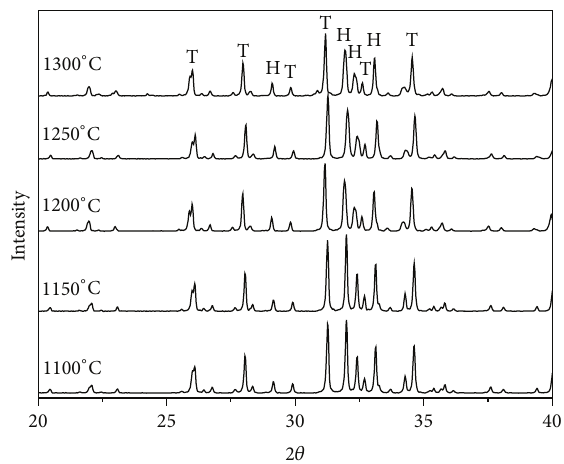
Figure 1: X-ray diffraction patterns of 60TCP40HA according to sintering temperature between 1100 ∘ C and 1300 ∘ C. T: tricalcium phosphate, H: hydroxyapatite, and 2 𝜃 : the take-off angle of the diffracted X-ray beam (spot) relative to the main